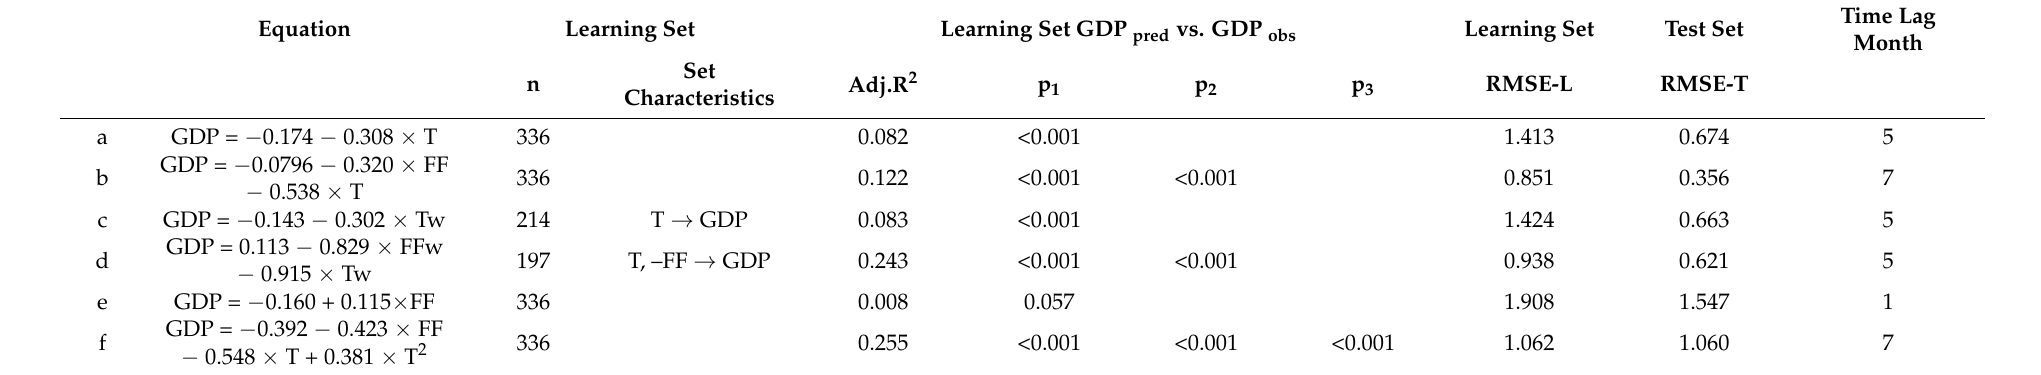
Table 2. Regressions for GDPo as a function of treasury yield, T, and federal funds rate, FF. Equation Learning